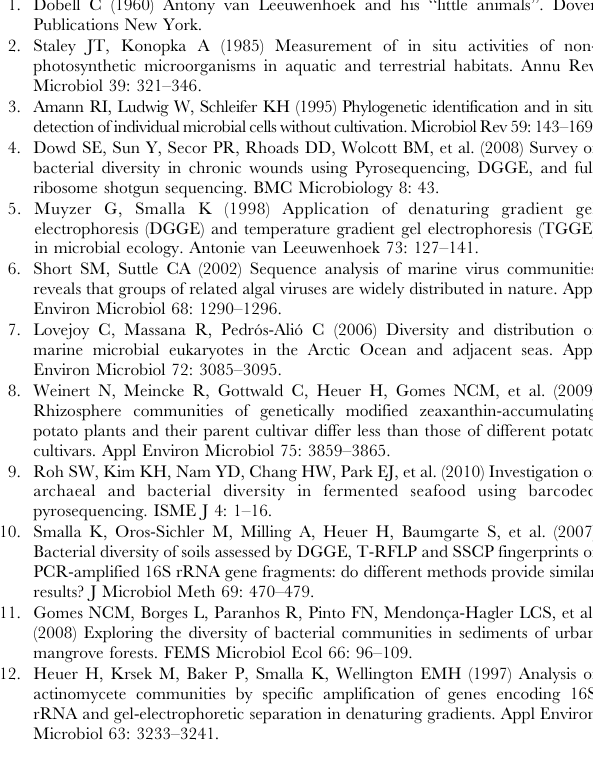
Figure S3 Principal coordinate (PCO) analysis. The first two axes of a PCO ordination are shown based on a matrix of OTU composition of Alphaproteobacteria . Results are shown for various cut-off levels using pyrosequence data (a–f) and DGGE fingerprint data (g). The results of adonis analyses are shown in the lower right corner of each figure. Figure S4 Principal coordinate (PCO) analysis. The first two axes of a PCO ordination are shown based on a matrix of OTU composition of Betaproteobacteria . Results are shown for various cut- off levels using pyrosequence data (a–f) and DGGE fingerprint data (g). The results of adonis analyses are shown in the lower right corner of each figure. (TIF) Figure S5 Relative abundance of the most abundant bacterial classes () with the exception of the Deferribacteres class, which was slightly more abundant overall than the Betaproteobacteria class. Bars represent the mean relative abundance for each microhabitat and error bars represent a single standard